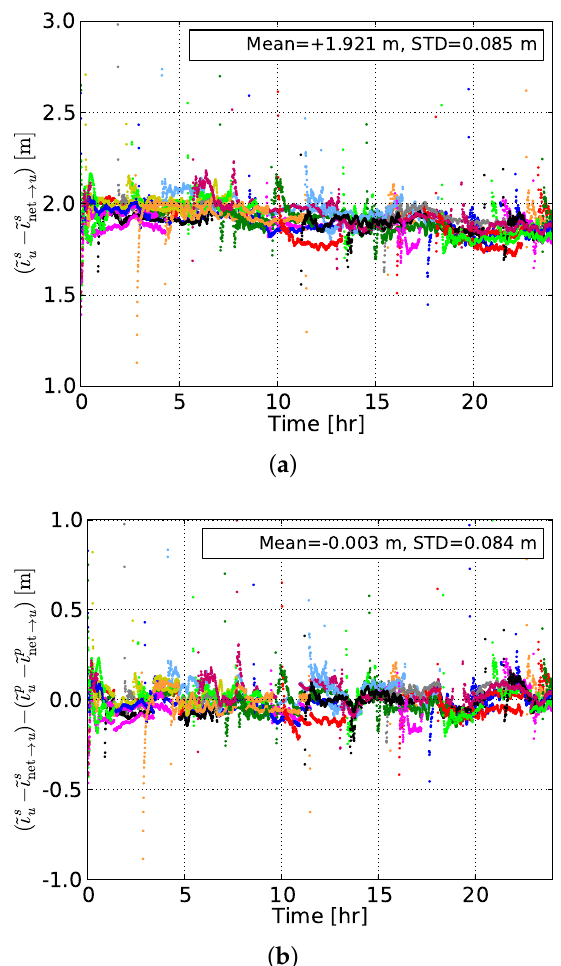
Figure 5. ( a ) Differences (in meters) of the undifferenced regionally network-derived user-predicted slant ionospheric delays and their counterparts estimated by the user NCWL, and ( b ) their between-satellite single-differenced results. Each color represents a different GPS satellite. This ionospheric correction prediction is referred to network #2 (mean station spacing of 115